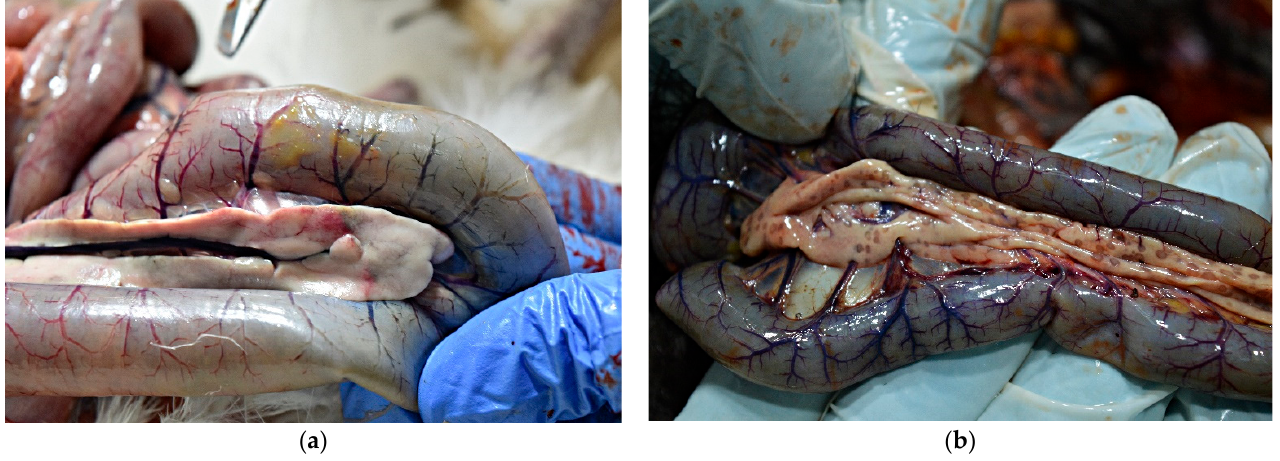
Figure 4. Gross lesions in chickens naturally infected with HPAI H5N8. ( a ) Extensive congestion and hemorrhages in the pulmonary parenchyma. ( b ) Severely congested ovarian follicles.